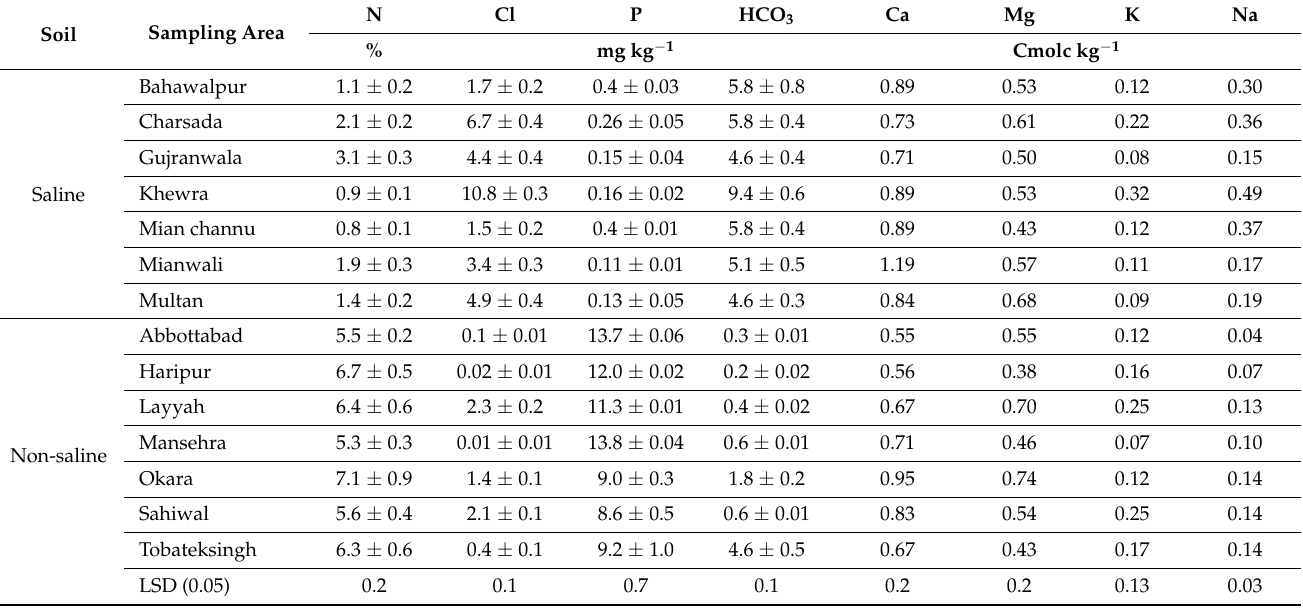
Table 4. Chemical properties of saline and non-saline